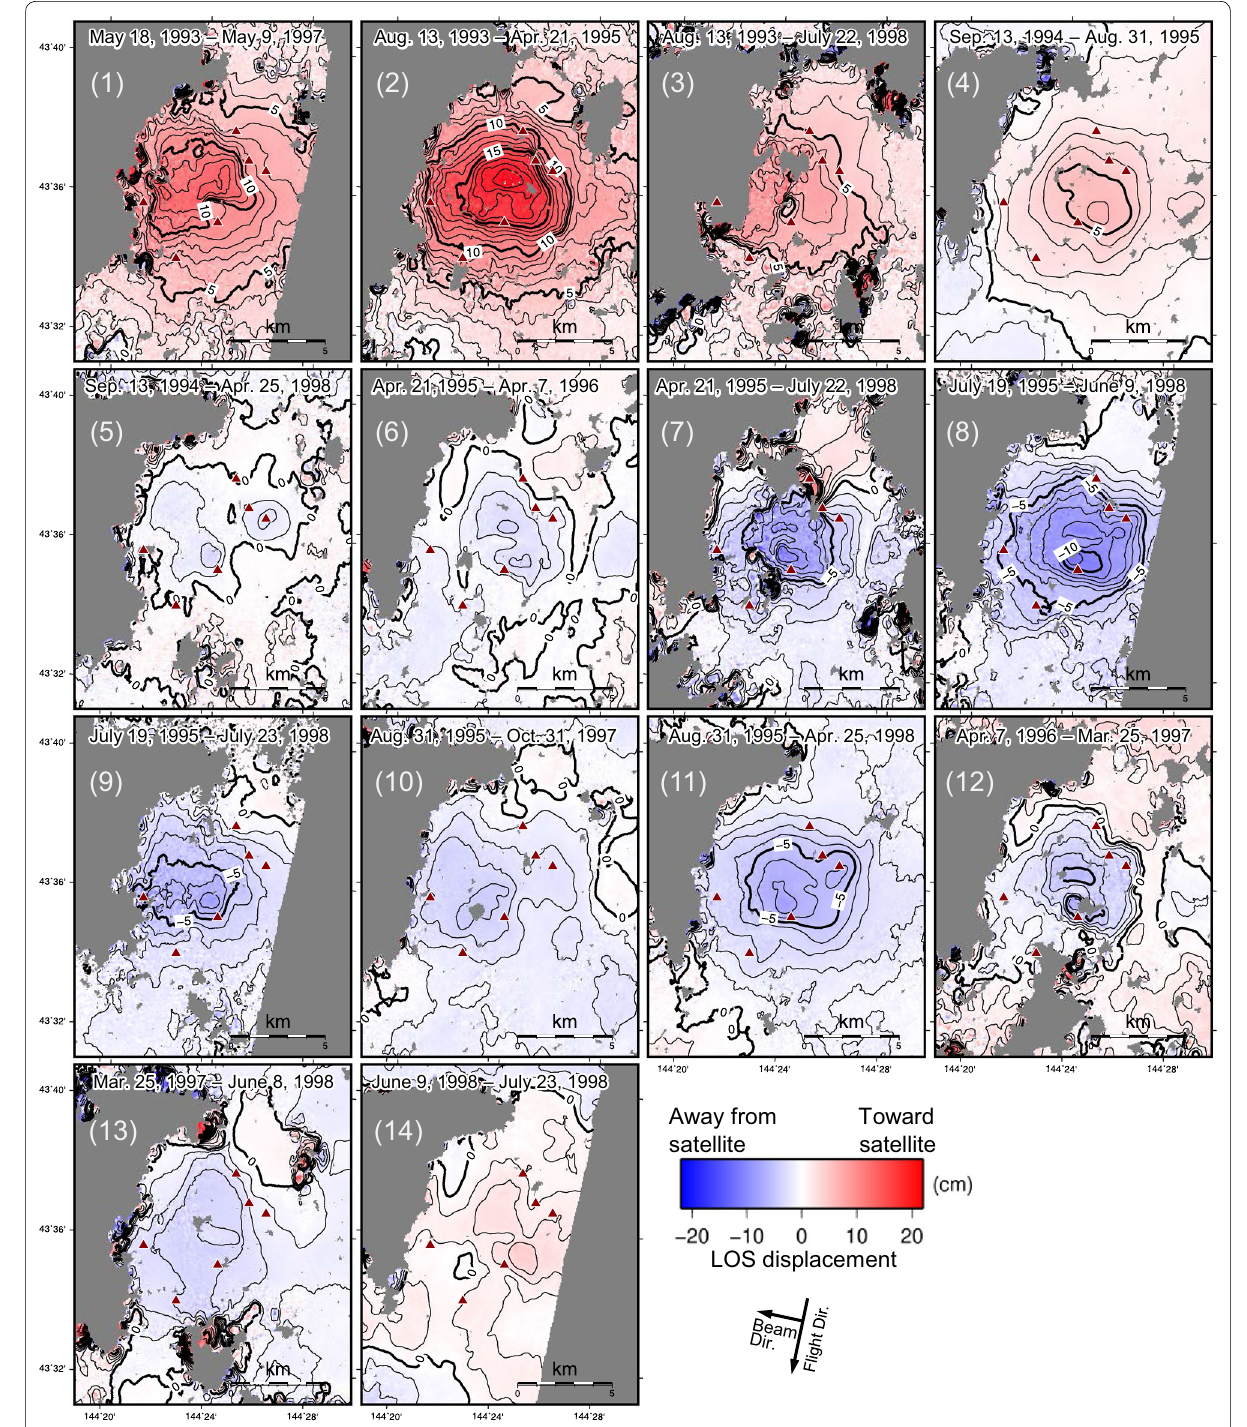
Fig. 2 Unwrapped SAR interferograms of JERS-1 used in this study. Each number indicates the InSAR pair in Table 1. Red triangles indicate major lava domes belonging to the Atosanupuri volcanic complex. Contour interval is 1 cm. The target area is shown in Fig.